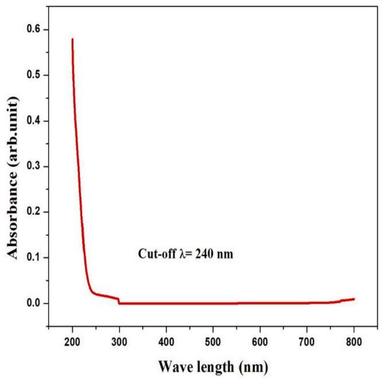
UV–visible spectra of UGA